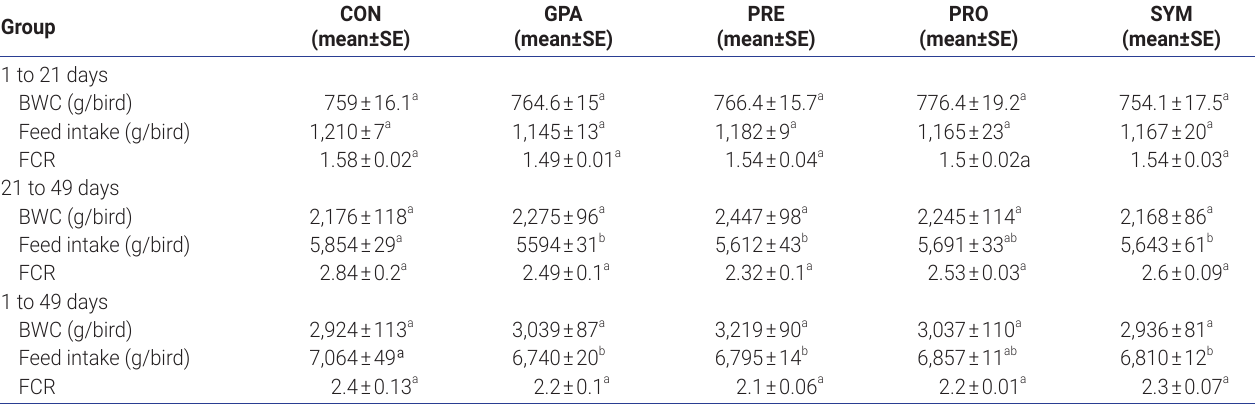
Table 2. Effect of the inclusion of encapsulated additives on the growth performance of broilers Group